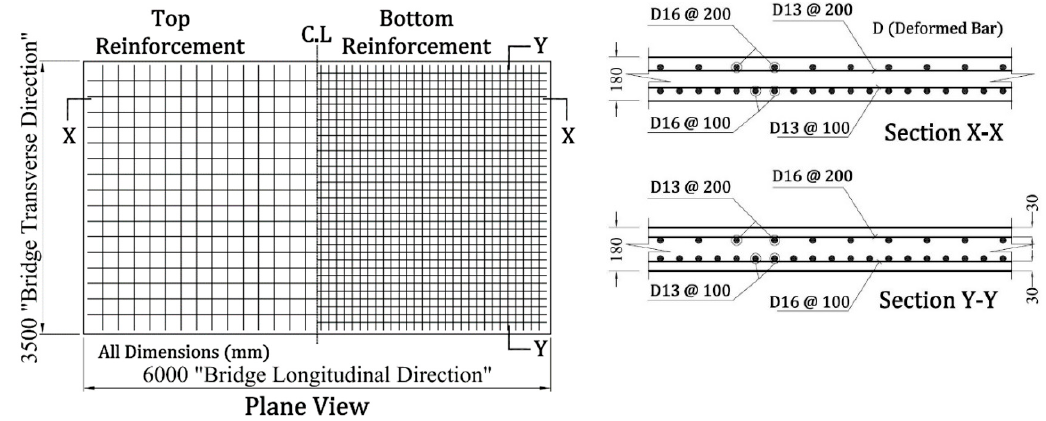
Figure 4. Dimensions and reinforcement of the reinforced concrete (RC) deck discussed.